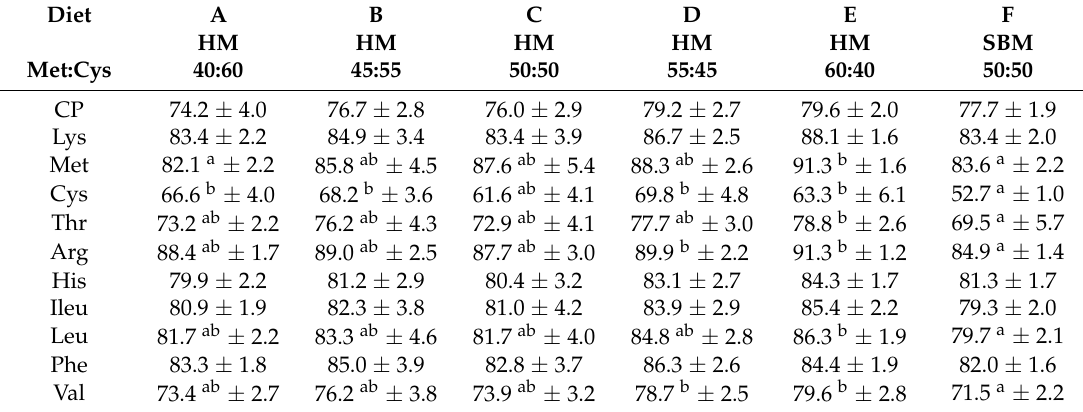
Table 5. Apparent precaecal digestibility (%) of crude protein (CP) and selected amino acids in the experimental diets ( n = 5) 1 .